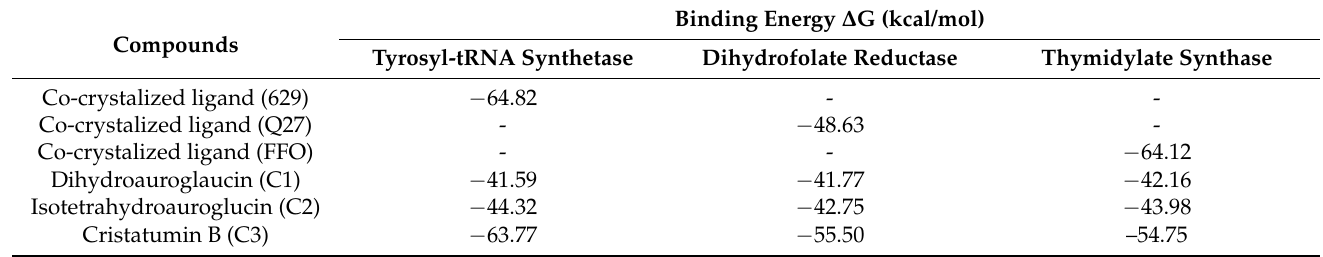
Table 4. Free binding energies ( ∆ G) of the identified compounds within the 1JIJ, 3SRW and 6 qxs